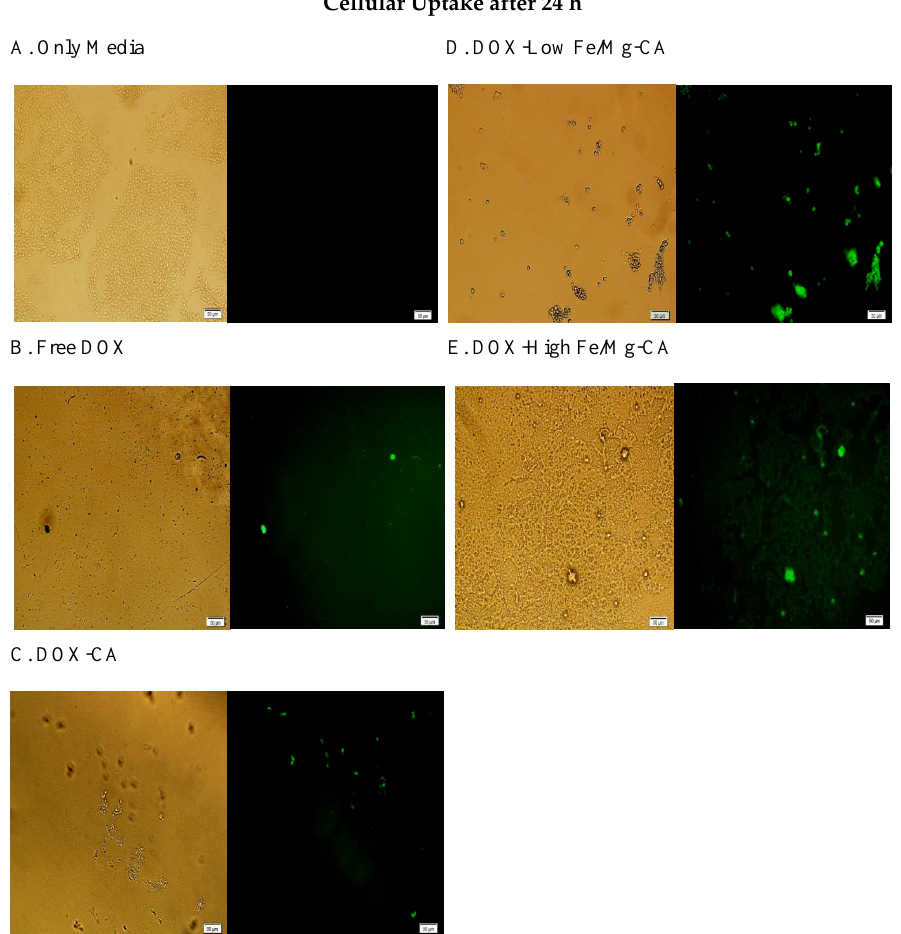
Figure 14. Representative images of cellular uptake in MCF-7 cells after 24 h of treatment. ( A ) Only media ( B ) Free DOX (5 µM DOX) ( C ) DOX-loaded CA (5 µM DOX, 4 mM Ca 2+ ) ( D ) DOX-loaded low Fe/Mg-CA (5 µM DOX, 4 mM Ca 2+ ,1 µM Fe 3+ , 4 mM Mg 2+ ) ( E ) DOX-loaded high Fe/Mg-CA (5 µM